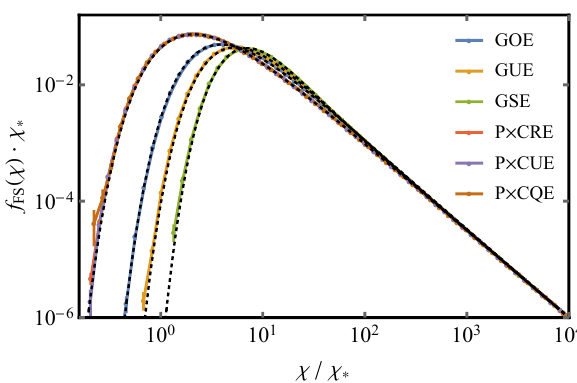
( χ ) of the fidelity susceptibility in random matrix the- Figure 3: The distribution f FS ory ensembles: Numerically calculated distributions of the fidelity susceptibility (solid colours, error bars indicate 68% confidence interval) are compared with analytic pre- dictions (black, dotted). The numerical distributions are obtained by histogramming the fidelity susceptibility (28) of mid-spectrum states obtained from exact diagonal- isation. In each case the distribution has been re-scaled by the maximum entropy ) . The dotted curves have no fitted parameters in the case of the Pois- value χ (cid:63) ( 0, h S son (see (39)) and GUE (see (51a)) ensembles. For GOE and GSE the dashed line has the exact limiting behaviour given by (47) and (49) whereas values of f at inter- FS mediate values of χ is obtained by a one parameter fit (details in text). Parameters: = 0.1, d = 2048, N = 3000 realisations for GSE and P × CQE, N = 10 5 realisations h S